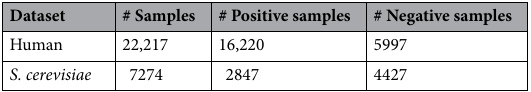
Table 1. Characteristics of PPIs